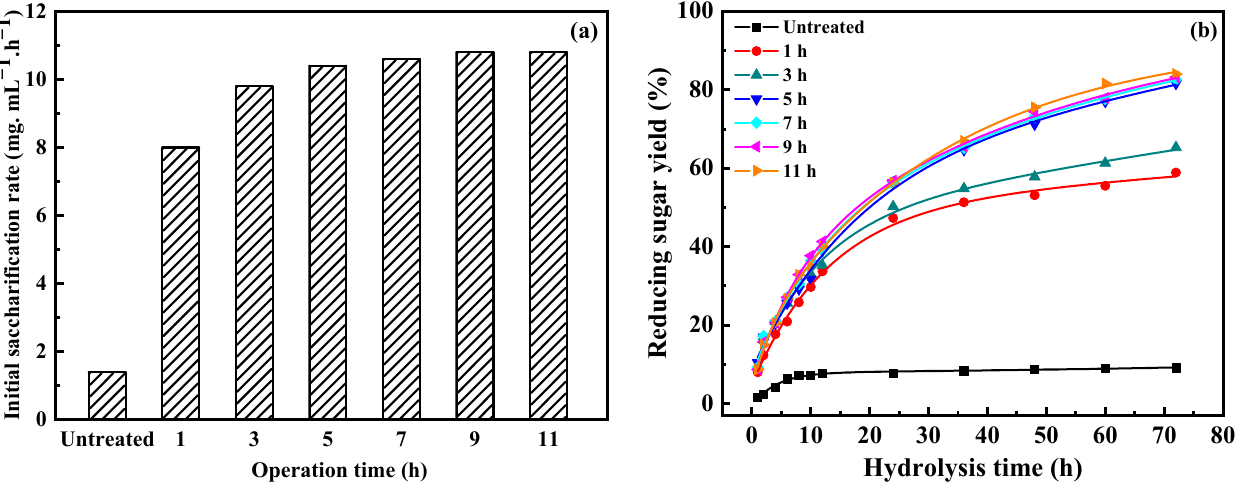
Figure 8. Influence of operation time on enzymatic hydrolysis: ( a ) initial saccharification rate, and ( b ) reducing sugar yield.